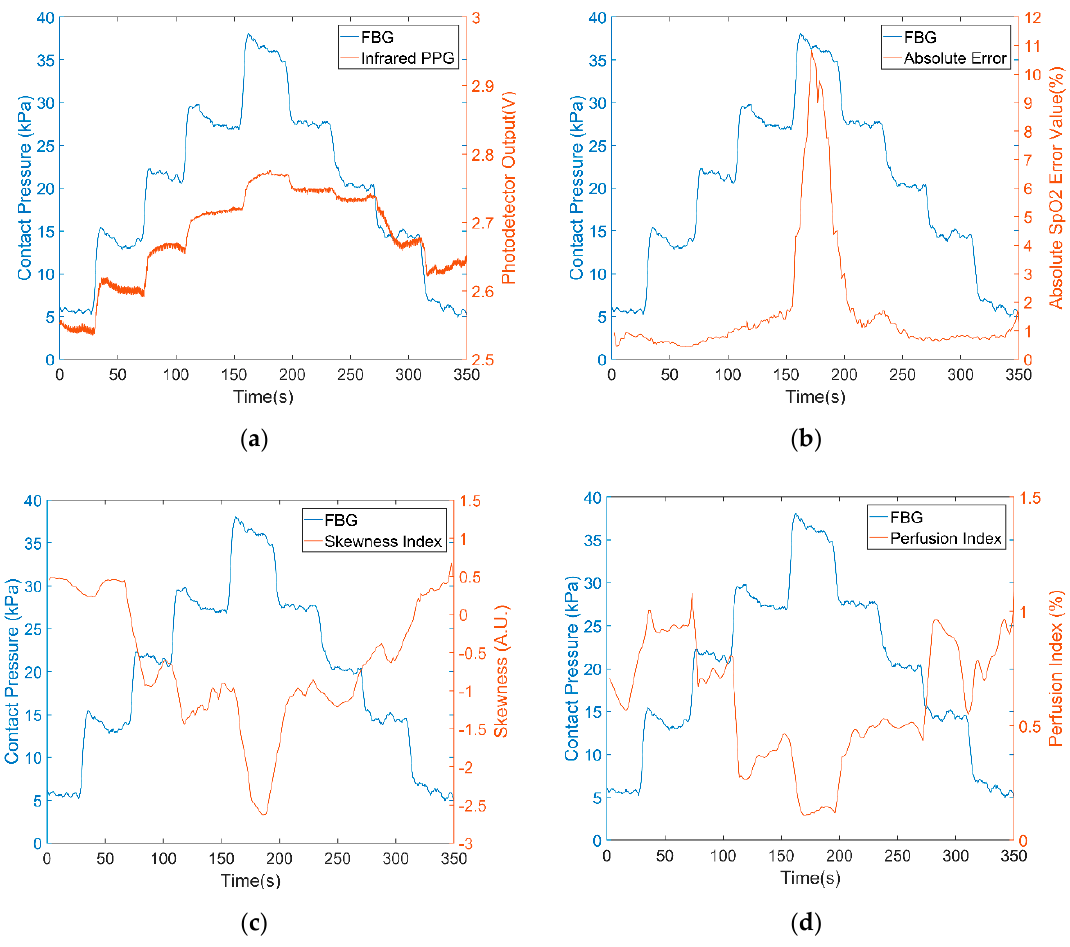
Figure 7. ( a ) Infrared PPG signals (red) under different contact pressures (blue). ( b ) Absolute S P O 2 error (red) compared to an unloaded commercial device ( c ) skewness index of infrared PPG (red) ( d ) Perfusion index of infrared PPG (red).